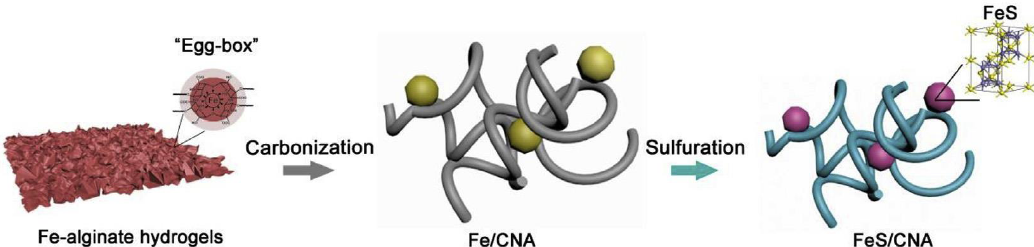
Figure 14. Schematic of the synthesis process of FeS nanoparticle-loaded carbon nanofiber aerogel from alginate salt. Reprinted with permission from [50]. Copyright © 2019 Elsevier B.V.